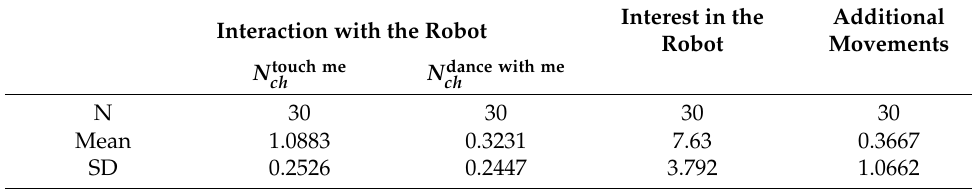
Table A2. Cumulative statistics. Typical development.